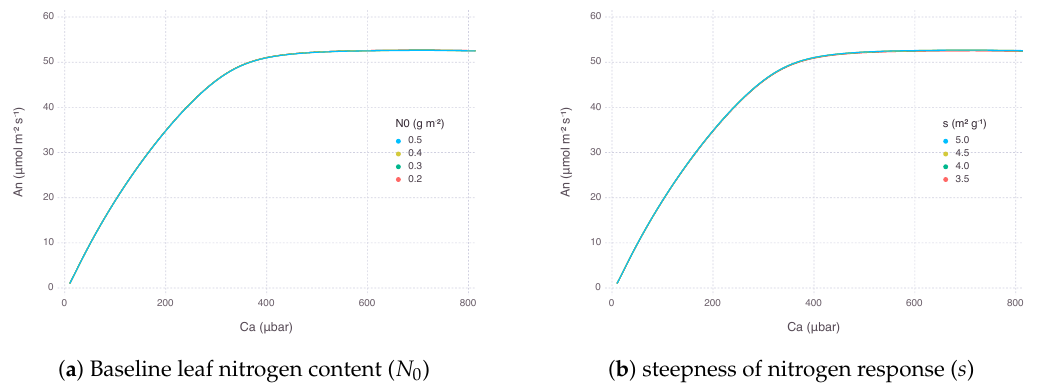
Figure A7. Sensitivity of parameters related to nitrogen dependence. The coupled gas-exchange model with Medlyn stomatal conductance model was used for testing. Air temperature ( T a ) was 32 ◦ C, irradiance ( I ) was 2000µmol quanta m − 2 s − 1 , and relative humidity (RH) was